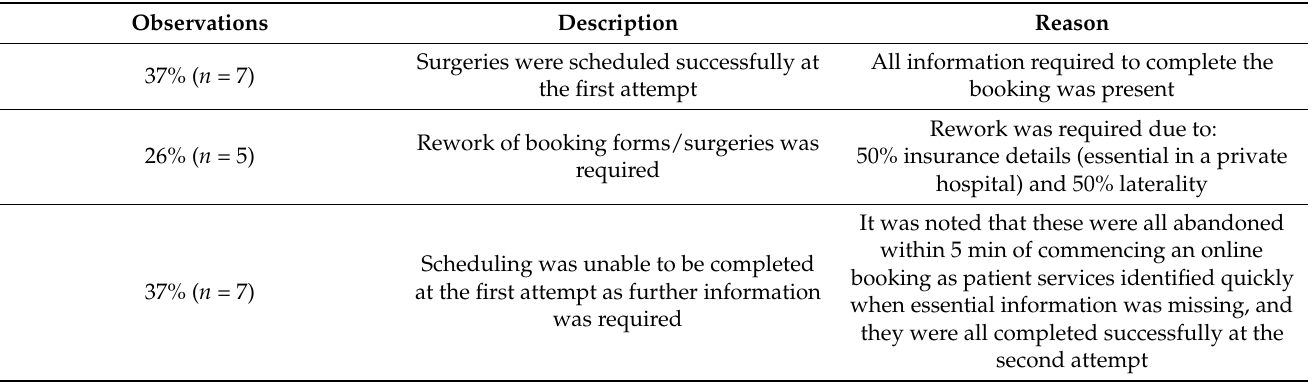
Figure 4. Time from OPD appointment to the scheduling of surgery. Table 3. Results from observing an online booking/as is